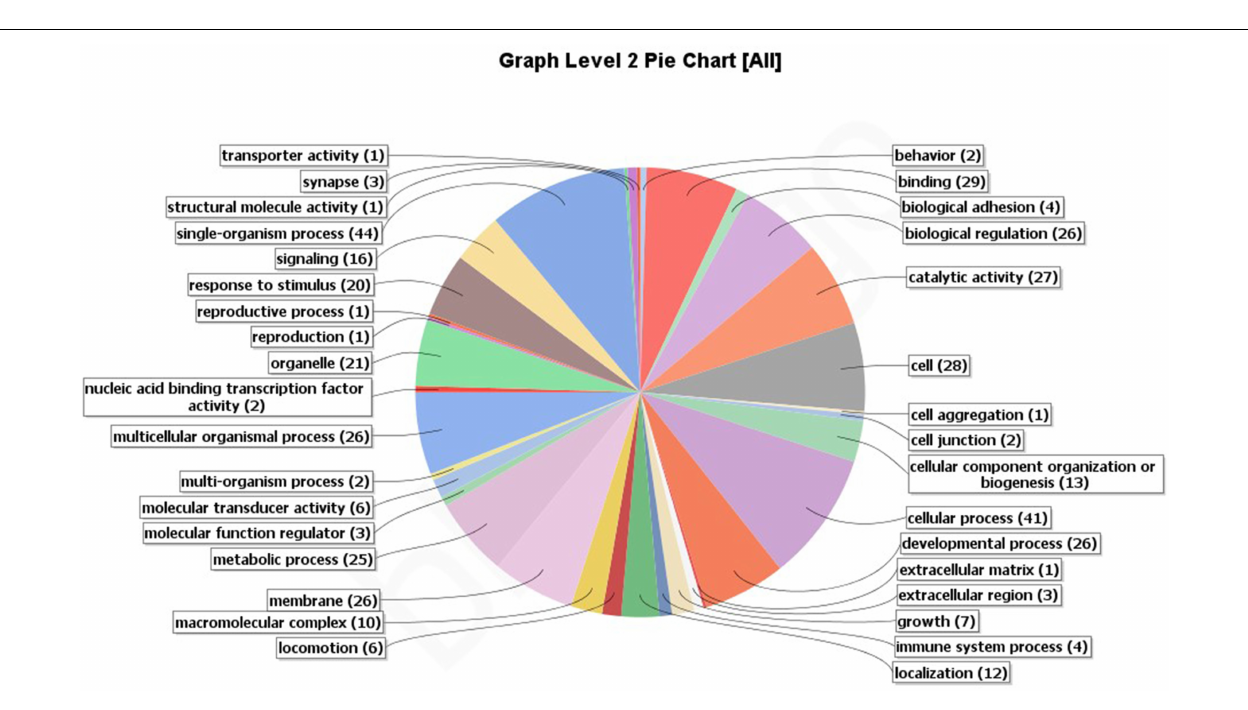
FIGURE 3 | The numbers of the annotated contigs.